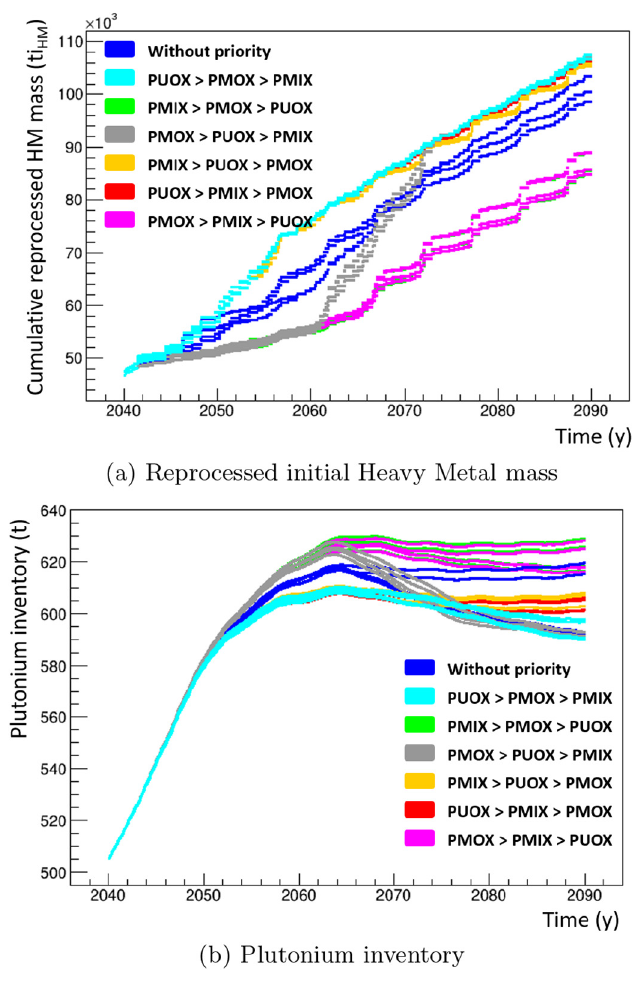
Fig. 8. Correlation between reprocessed HM mass and global plutonium